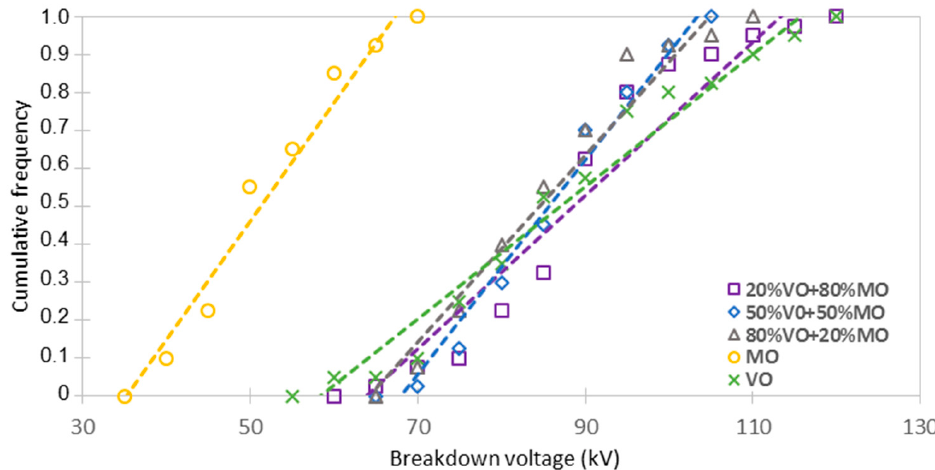
Figure 13. Linear trend of the cumulative frequency of AC breakdown voltage of mineral oil and natural ester mixtures.